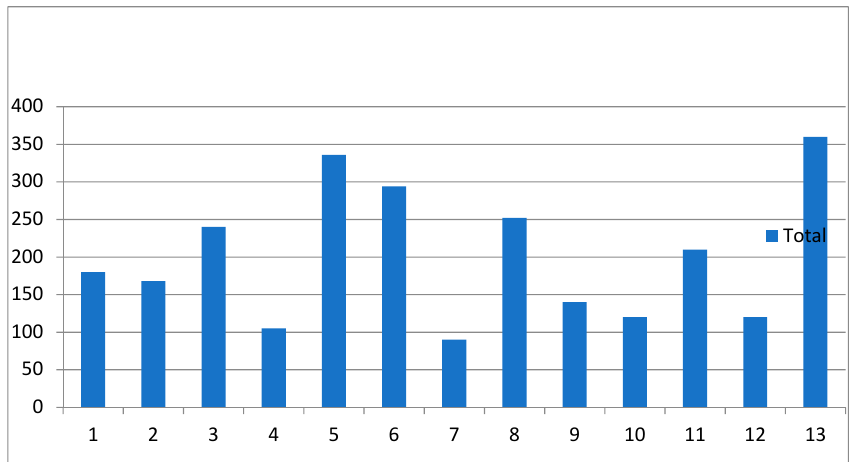
Figure 11. Distribution of failure causes to RPN for ware transfer mechanism.